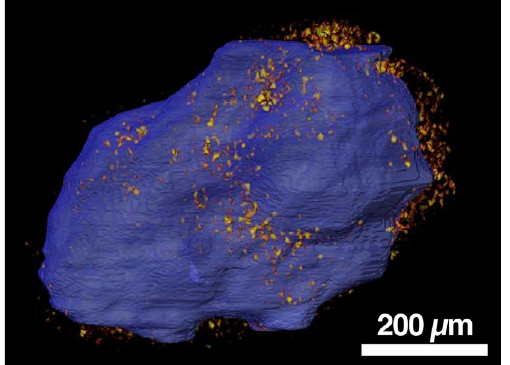
Figure 5. Three-dimensional rendering of chondrule surface (blue) and areas of highest porosity (> 35%) (orange to yellow; same color scale as in Fig. 4) within the FGR. Highest porosity within FGR is localized on the ‘right’ side of the chondrule, and mostly on the ‘top’. The highest porosity regions within the FGR are not consistent layers around the chondrule but isolated patches with a complex geometry. See Supplemental Material for 3D